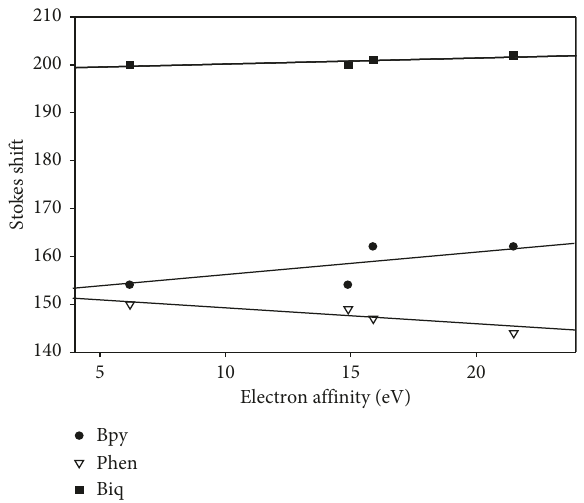
Figure 3: Stokes shift plotted as function of the electron density of the polypyridyl ligand terminal